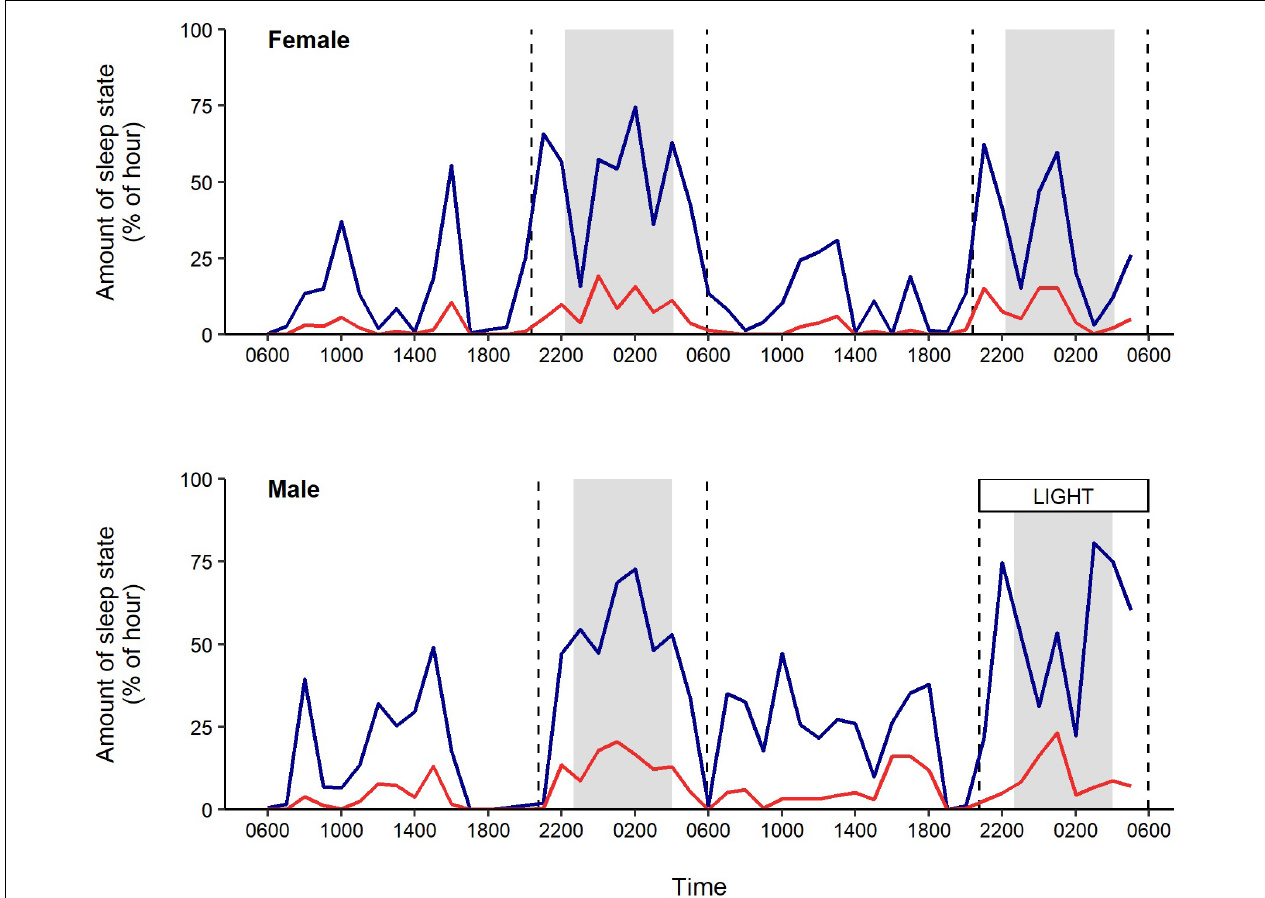
FIGURE 4 | Percentage of time spent in non-REM (blue) and REM sleep (red) per hour in an adult female and male black swan. The male swan was exposed to light from white streetlights throughout the second night. Sunrise and sunset times are marked by dashed vertical lines; astronomical night is shaded in